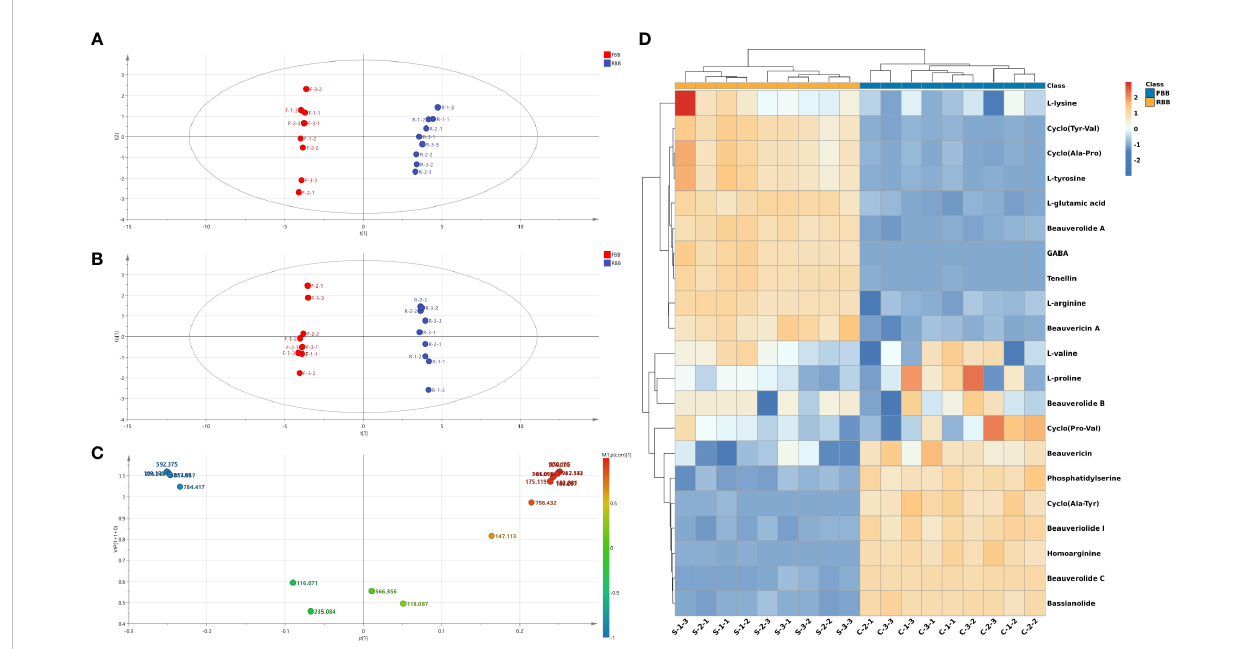
FIGURE 3 Multivariate statistical analysis of MALDI-TOF-MS data from raw and fried Bombyx batryticatus samples. (A) PCA score plot. (B) OPLS-DA score plot. (C) VIP diagram. (D) HCA heatmap.